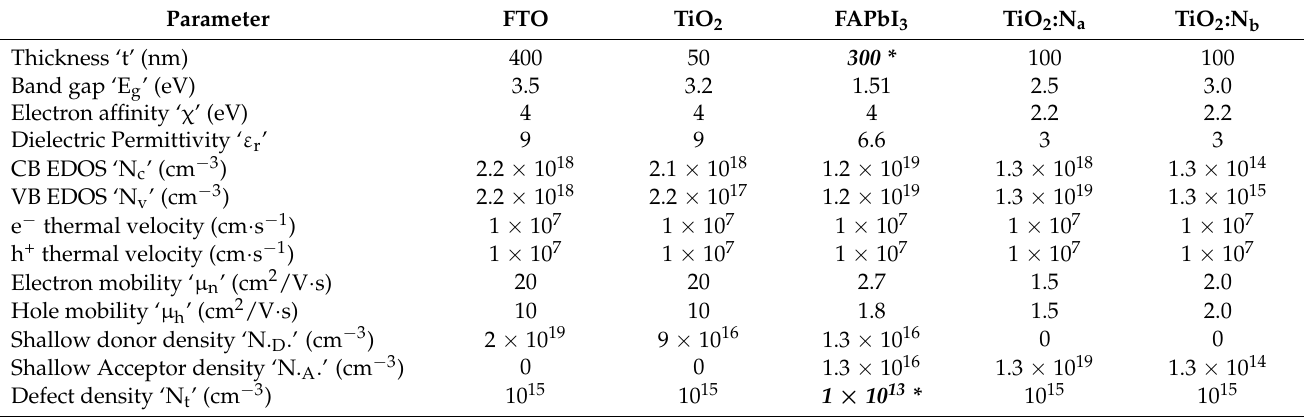
Table 3. Simulation parameters of different layers within the PSC structure [34,38,63,64].